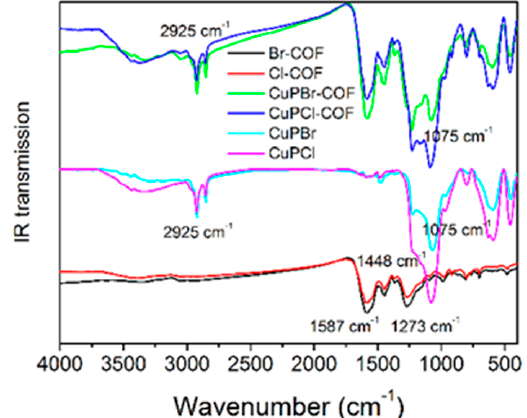
Figure 6. IR spectra of CuPX, CuPX-COF and X-COF, X = Br, Cl.